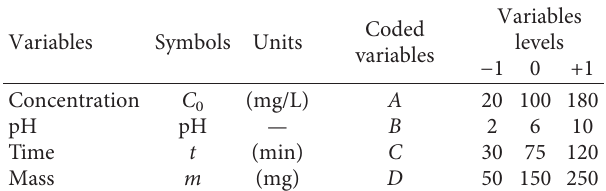
Table 2: Matrix of coded variables.